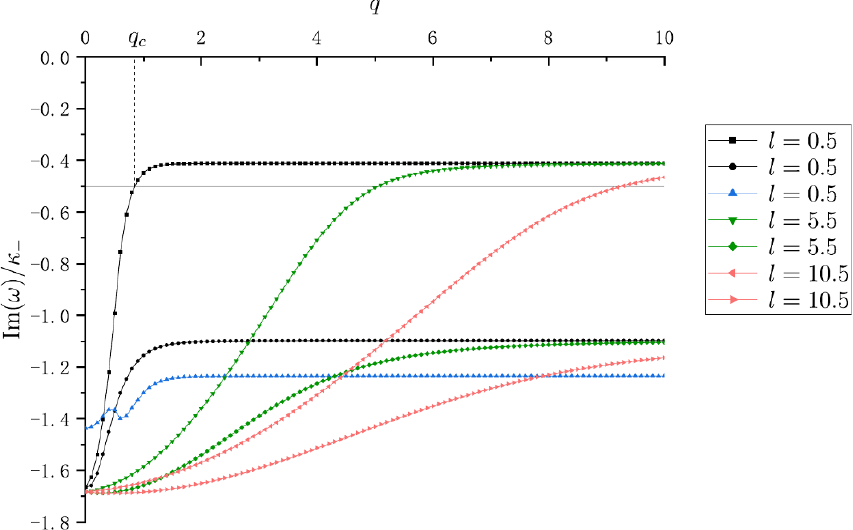
Figure 3 . The low-lying QNMs for (cid:3) = 0 : 06 and Q=Q max = 0 : 999, where the blue line